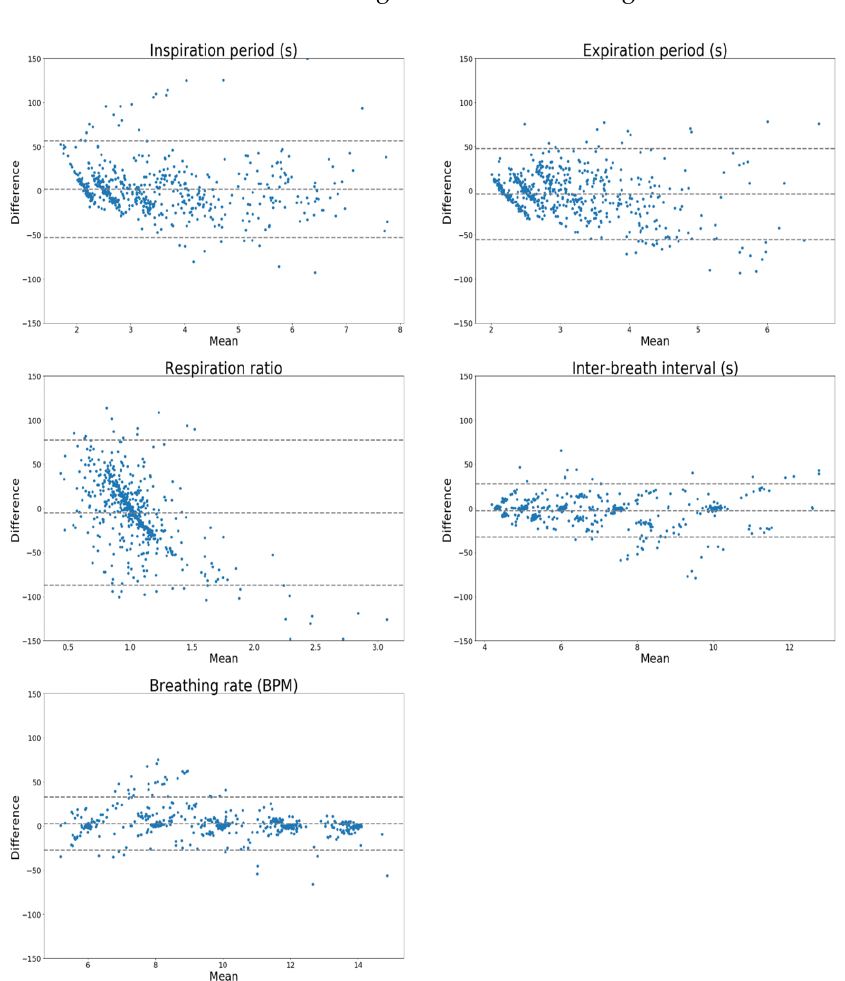
Figure 5. Bland–Altman agreement expressed as percent differences for LSTM architecture.